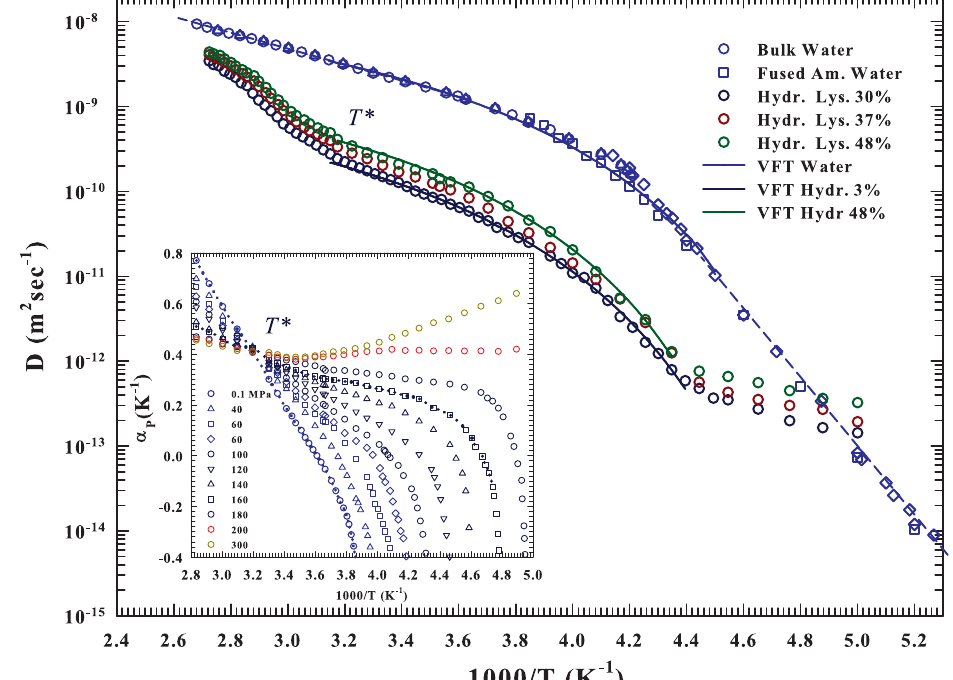
Figure 1. The Arrhenius plot ( lnD S vs. 1000/ T ) of the proton self-diffusion D S ( T ) measured in the lysozyme at three different hydration levels: h = 0.3,0.37 and 0.48, together with those of pure liquid water. The studied temperature range is, for water, 180 < T < 373, wheras for hydrated lysozyme 200 < T < 367. The inset reports the pure bulk water expansion coefficient α P in the P , T plane. The corresponding data behaviors well illustrate the thermodynamic singularity of the temperature T ∗